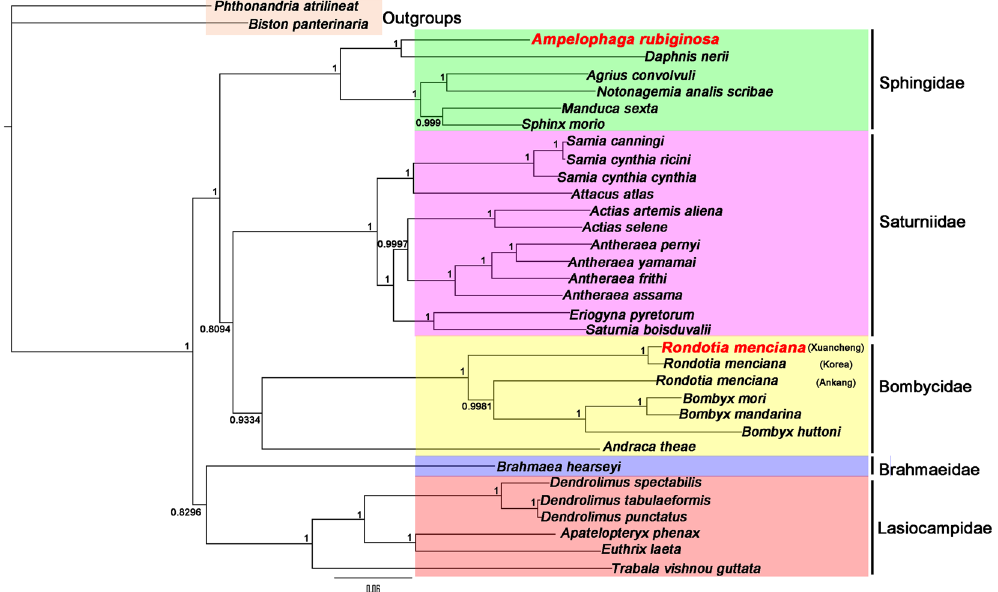
Figure 6. Phylogenetic tree derived for Bombycoidea using BI analysis based on nucleotide sequences using MAFFT for